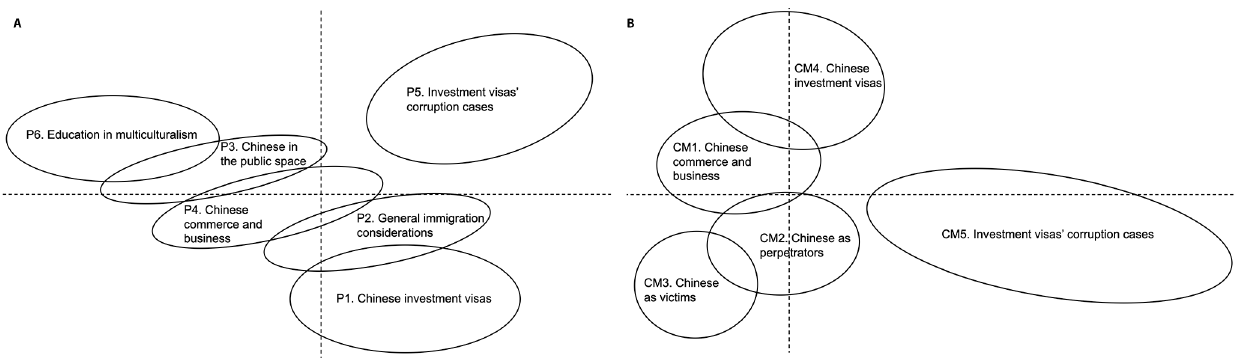
Figure 1. Factorial correspondence analysis of themes in Público (Pane A) and in Correio da Manhã (Pane